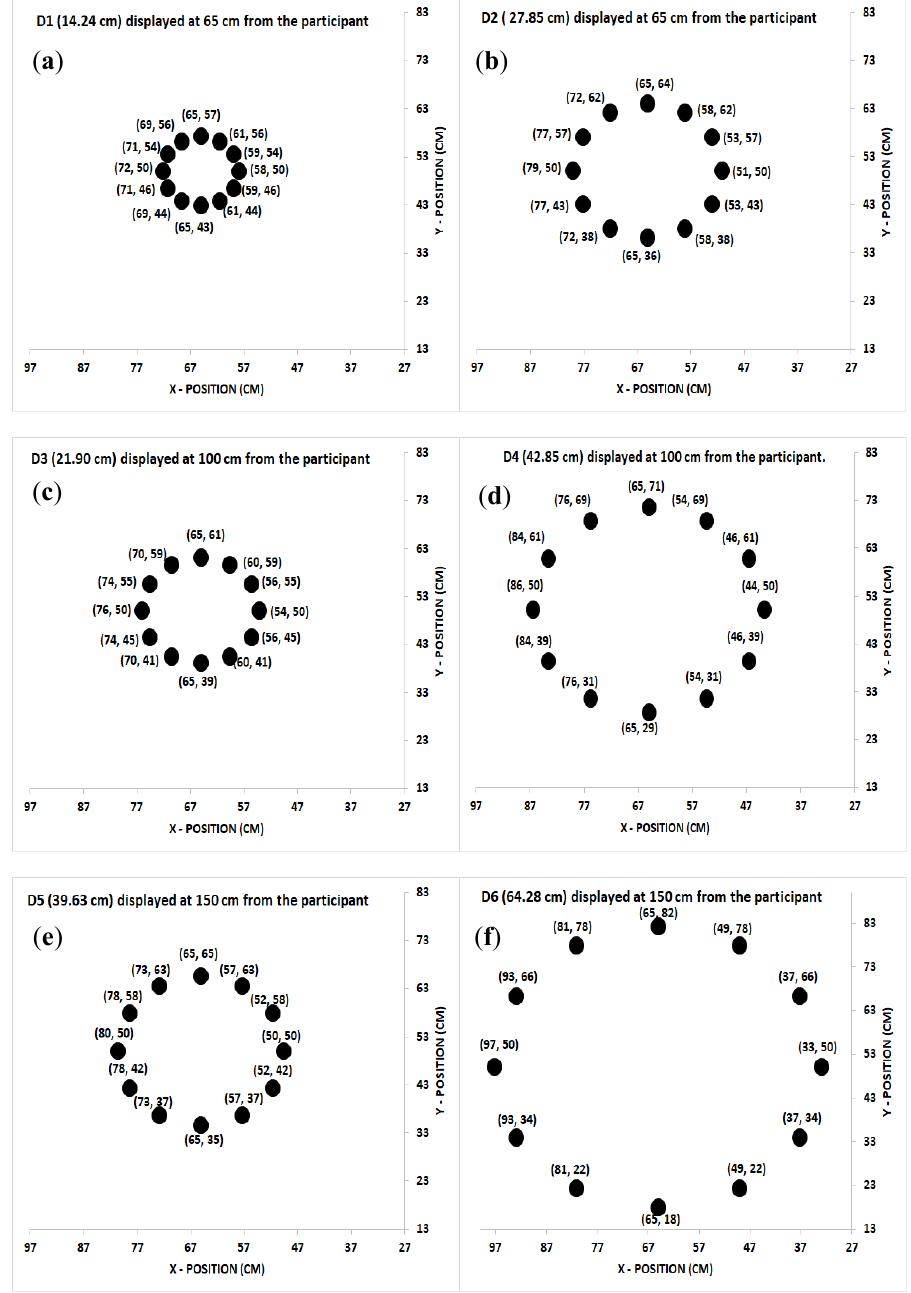
Figure 3. Presentation of the virtual targets ( a-f ) in the frontal plane of each target with the exocentric distance and target distance from the participant. The coordinates (in centimeters) are in reference to the global origin of the motion system, where it was set on the screen to the bottom right corner of the centerline of the sight of the